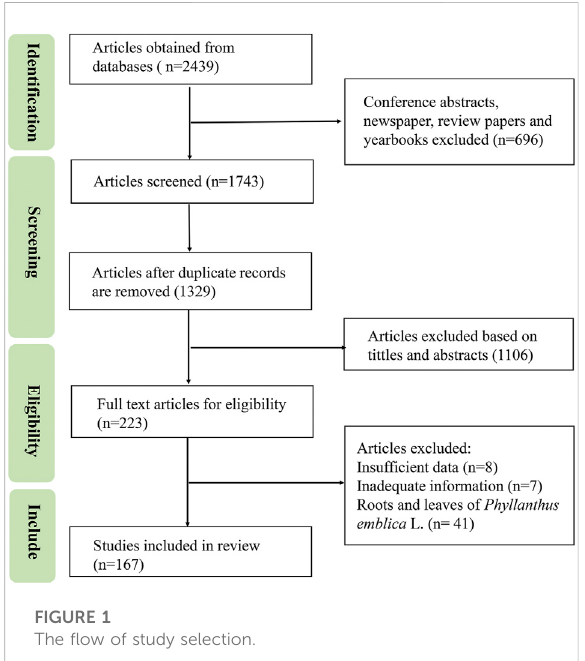
FIGURE 1 The fl ow of study